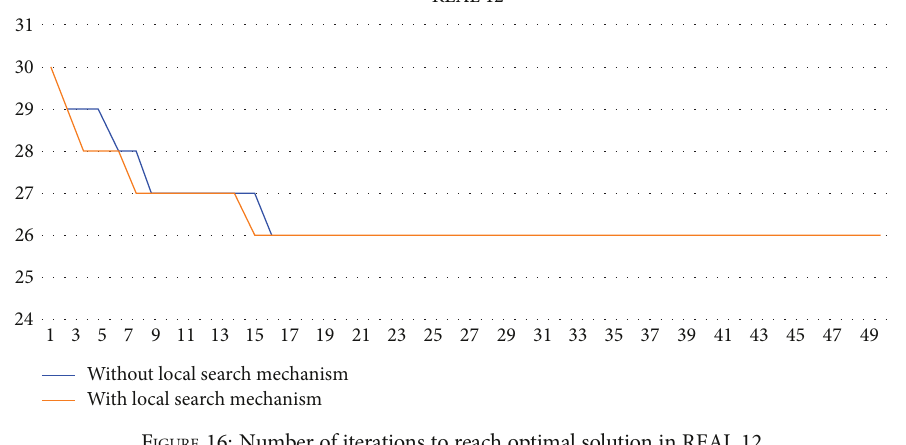
F IGURE 16: Number of iterations to reach optimal solution in REAL